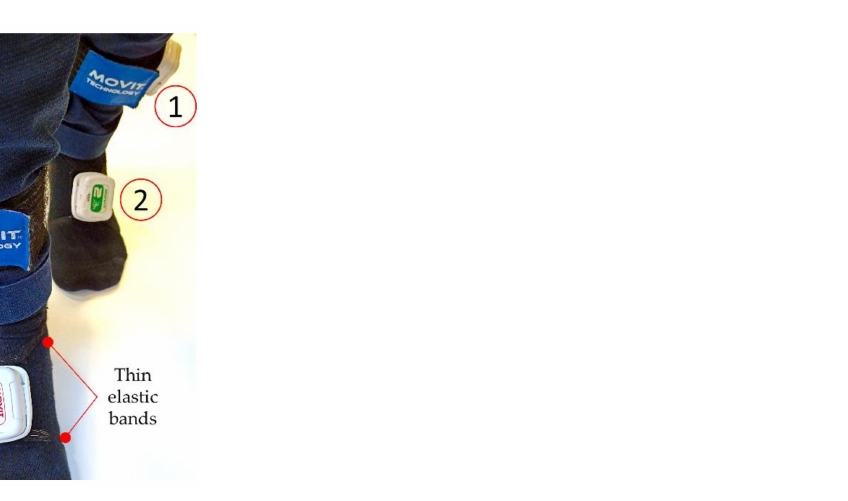
Figure 1. IMUs are placed, by means of Velcro strips, on both insteps (#2, #3) and on both shins (#1, #4). The “Motion Analyzer ® ” software (by Captiks, Rome, Italy), in bundle with the four “Movit G1”, provides the values of the angles (in degrees) assumed by the ankles during walking, from differentiating measurements from IMUs on insteps and shins,